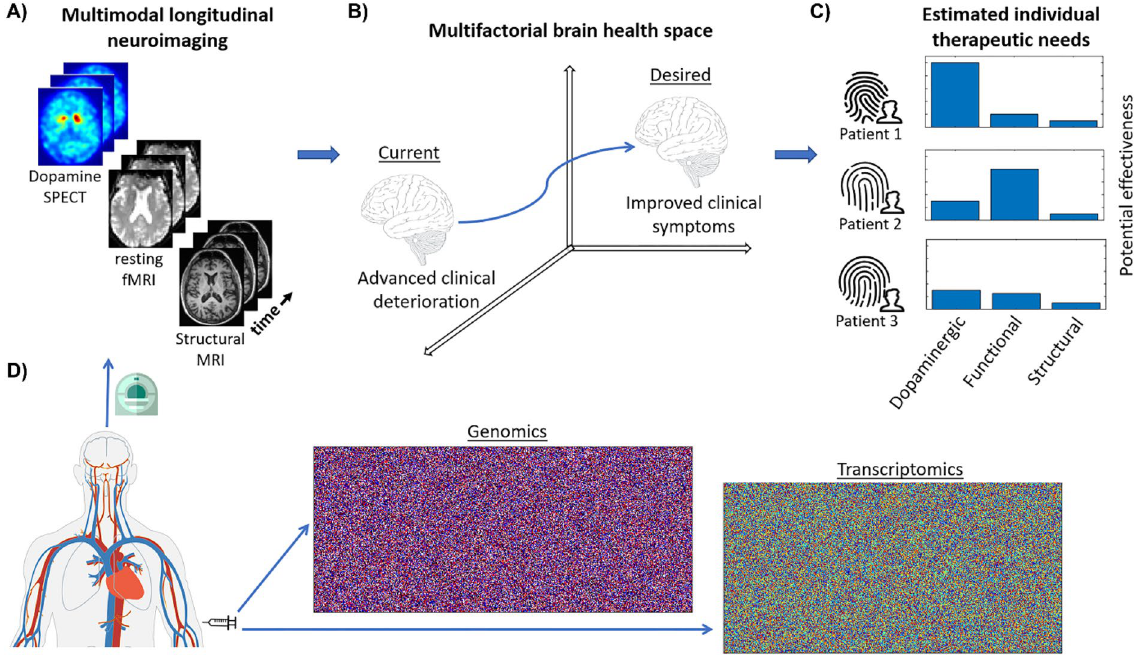
Figure 1. Workflow for multifactorial therapeutic intervention fingerprinting in PD. ( A ) Longitudinal imaging for dopamine SPECT, functional MRI at rest and/or structural MRI. ( B ) A network-based approach 7 allows individual characterization of intra-brain synergistic biological interactions and multifactorial spreading mechanisms through anatomical connections. Inverting the model’s fundamental equation allows estimation of the changes required to produce a desired clinical effect (i.e., conducing the patient’s brain from the current neurodegenerative state towards a healthier clinical condition). ( C ) Dissimilar pTIF patterns for three participants with the same diagnosis. For each patient, the pTIF is defined as the set of biological changes required, estimating how clinically effective it would be to target each analyzed biological process. In this example, note that Patient 1 would be more benefitted by a dopamine-based therapeutic intervention (e.g., Levodopa treatment), while for Patient 2 it would be more effective a functional intervention (e.g. Deep brain stimulation or Transcranial magnetic stimulation), suggesting the identification of specific single-target therapies that may benefit these patients. However, Patient 3 may not be clinically benefitted by any of these three single-target interventions, suggesting that combinatorial (and not single-target) treatments would be more appropriate in this case. For visual simplicity, in this figure only single-target interventions are represented, but for three neuroimaging modalities the pTIF includes 7 global values, corresponding to each modality and their combinations (see “Material and methods”, “Imaging-derived individual therapeutic needs estimation”). ( D ) Genomic and Transcriptomic data is collected for identifying the genetic basis of the estimated treatment needs in